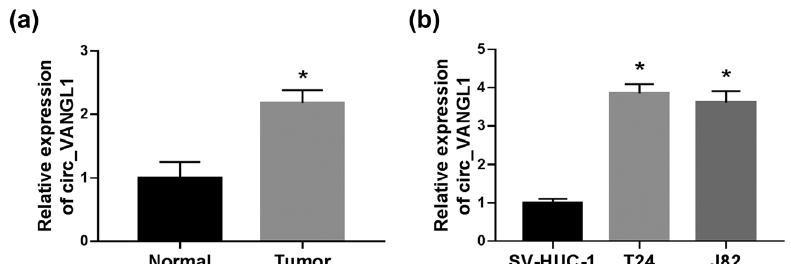
Figure 1: The level of circ_VANGL1 in bladder cancer tissues and cells. ( a ) RT - qPCR was used to detect the level of circ_VANGL1 in tumor tissues ( n = 36 ) and matched normal tissues ( n = 36 ) . ( b ) The level of circ_VANGL1 in bladder cancer cells ( T24 and J82 ) and human normal bladder epithelial cell line ( SV - HUC - 1 ) was measured by RT - qPCR. * P <